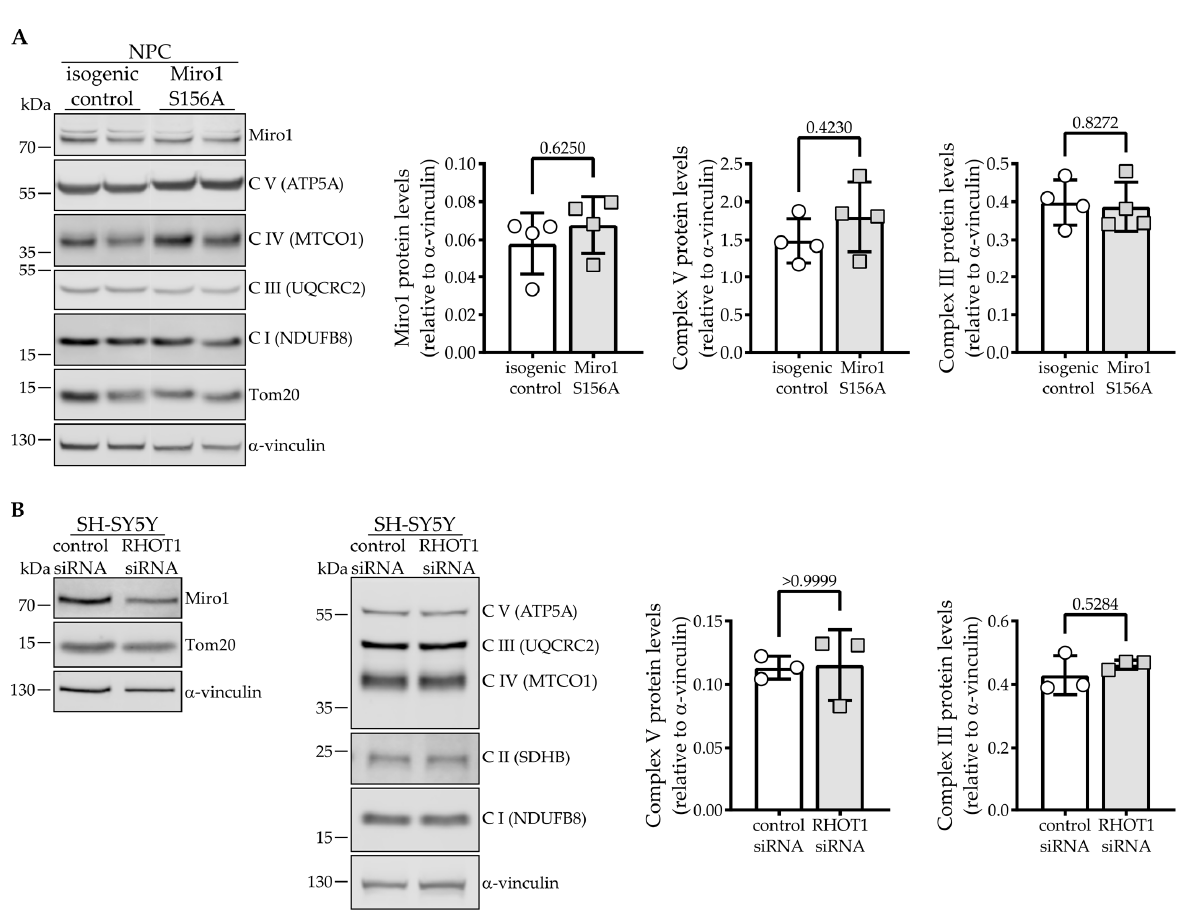
Figure 4. The S156A mutation reduces Miro1 protein levels affecting OXPHOS in postmitotic dif- ferentiated cells. ( A ) Representative Western blot showing Miro1, Tom20, complex V/IV/III/I in NPCs. Quantification of intensity of Miro1, complex V and III bands normalized to α -vinculin.